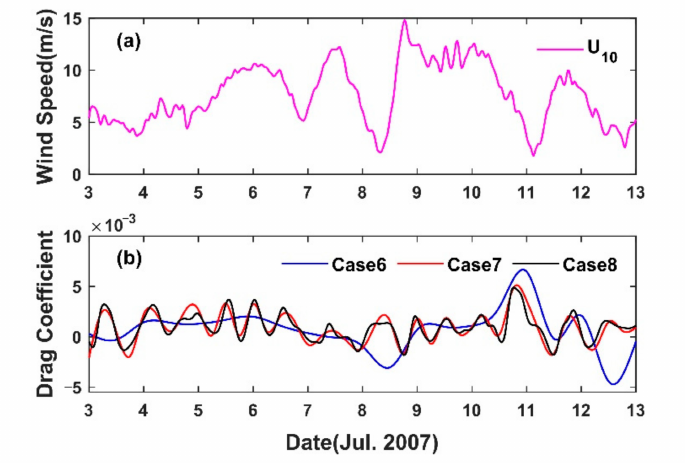
Figure 10. Practical experimental results; ( a ) is the time series distribution of wind speed U 10 , and ( b ) is the time series distributions of WSDCs of Case 6–8 using the CSI scheme, respectively. We also compared the time series of observed and inverted current velocities at 5 m